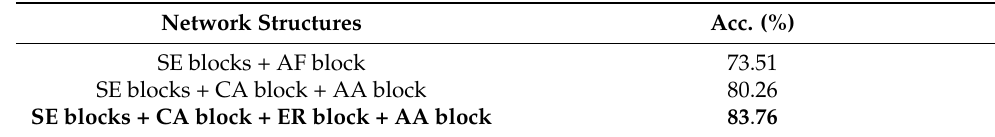
Table 4. Performance of emotion prediction on CAER-S test set using different networks. The networks of SE block + AF block and SE block + CA block + AA block are shown in Figure 9. The network of SE block + CA block + ER block + AA block is shown in Figure